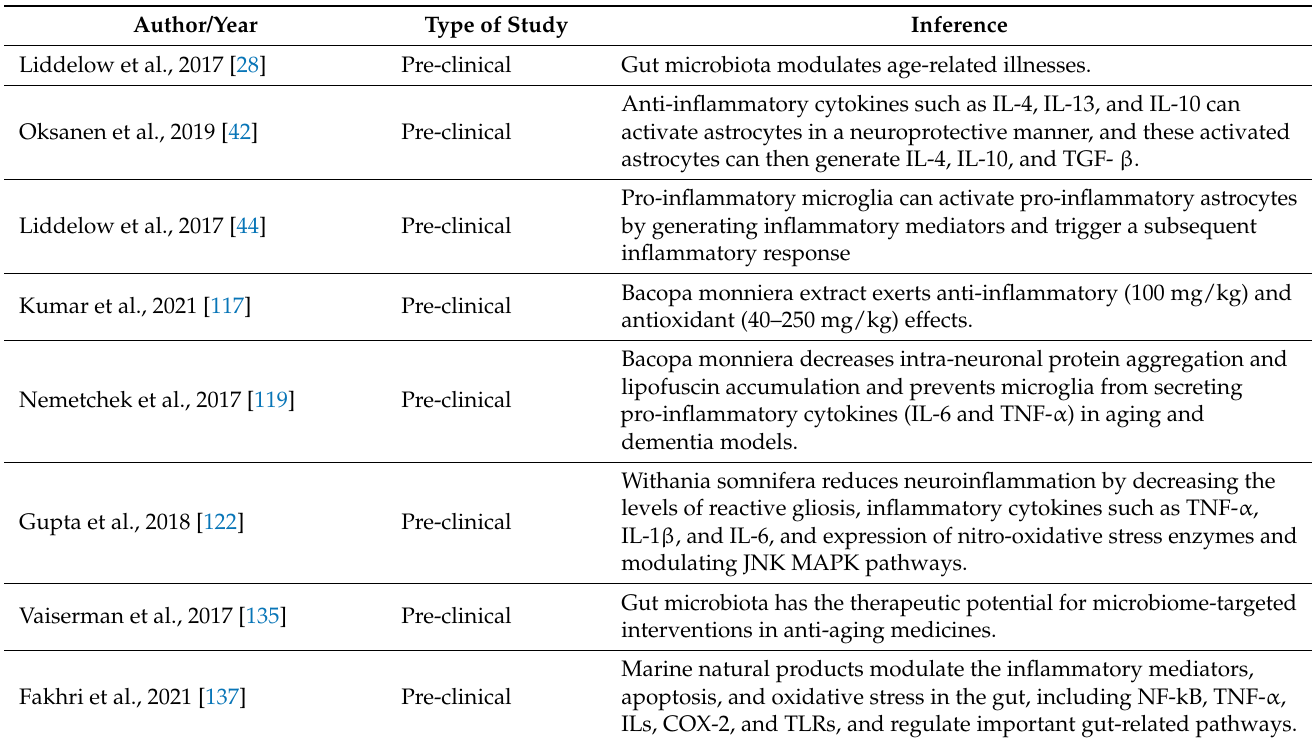
Table 1. Summary of the recent update on neuronutraceuticals and